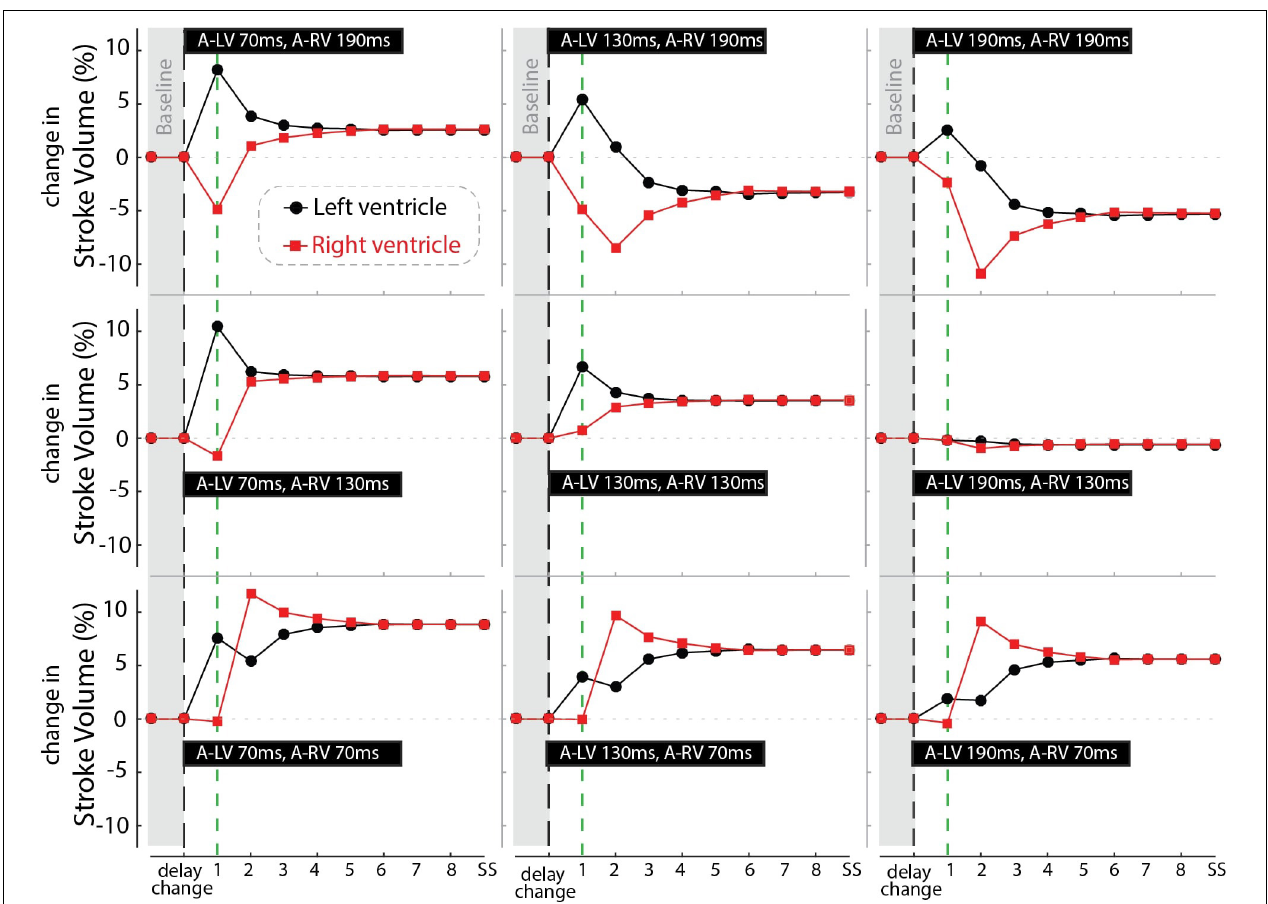
FIGURE 7 | Relative change in stroke volume of the left (black circles) and right (red squares) ventricle over a number of simulated cycles until steady-state (SS) after changing pacing delay (the nine settings shown in the black bars). Black dashed line indicates the moment of changing the pacing delays while the green line marks the first